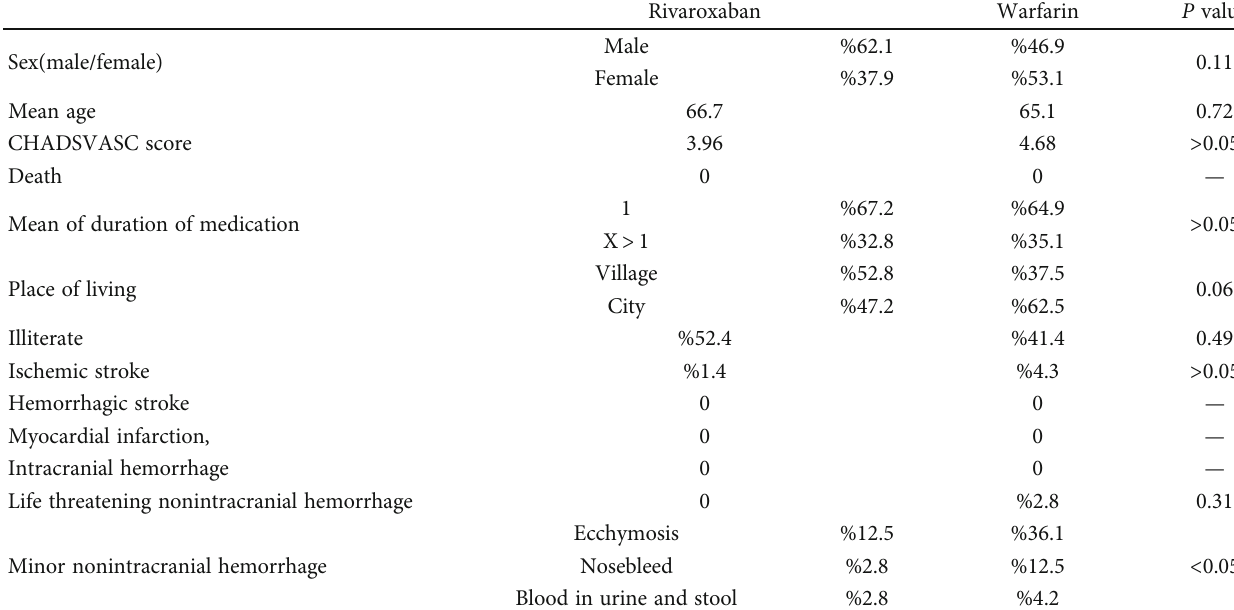
Table 2: Bleeding and ischemic stroke incidence of the AF patients treated with rivaroxaban and warfarin in